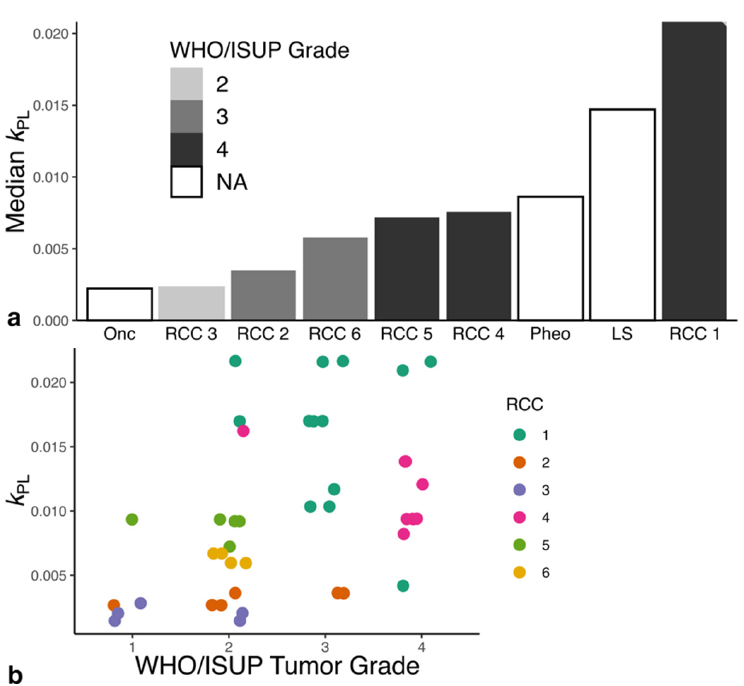
Figure 3. Comparison of the ISUP/WHO Grade with median k PL . ( a ) Increasing tumor grade was associated with increased metabolic activity in ccRCC. The liposarcoma and pheochromocytoma showed metabolic activity comparable to grade IV ccRCC. The benign renal oncocytoma showed the lowest metabolic activity. ( b ) An increase in k PL values was associated with an increasing tumor grade determined for the individual tumor biopsy. LS: Liposarcoma, Onc: Oncocytoma, Pheo: Pheochromocytoma, RCC: clear cell renal cell carcinoma.